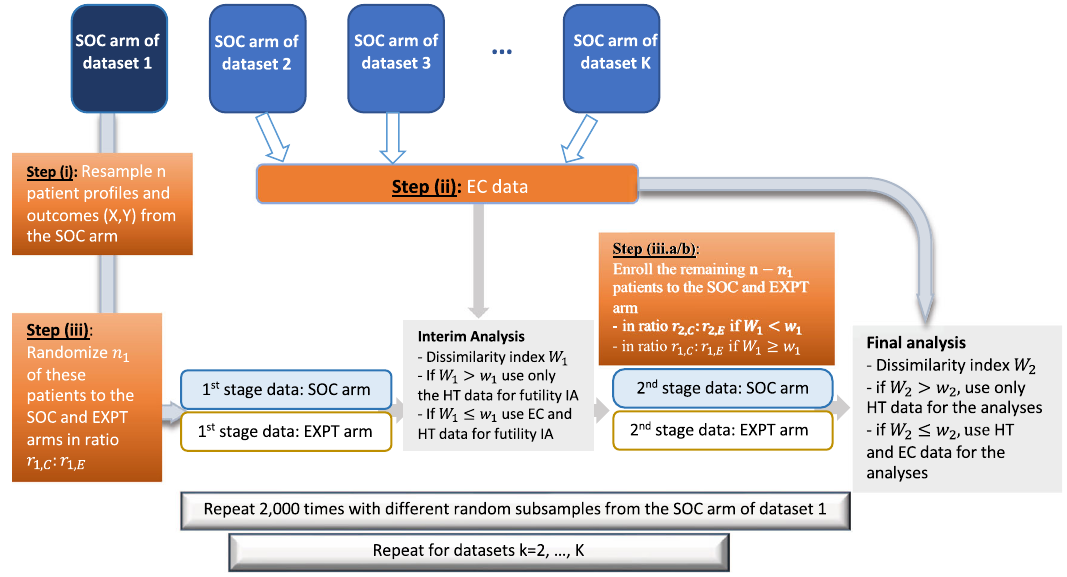
Fig. 3 | Graphical representation of the leave-one-study-out resampling algo- rithm. Step (i), we randomly sample with replacement n patient pro fi les and the corresponding outcomes from the control arm (SOC) of study k. Step (ii), we use the control arms of the remaining studies as externally controlled (EC) data. Step (iii)werandomize n 1 ofthepatientsinStep(i)totheexperimentaltreatment(EXPT) and the SOC arms of our in silico trial and compute the index W 1 :